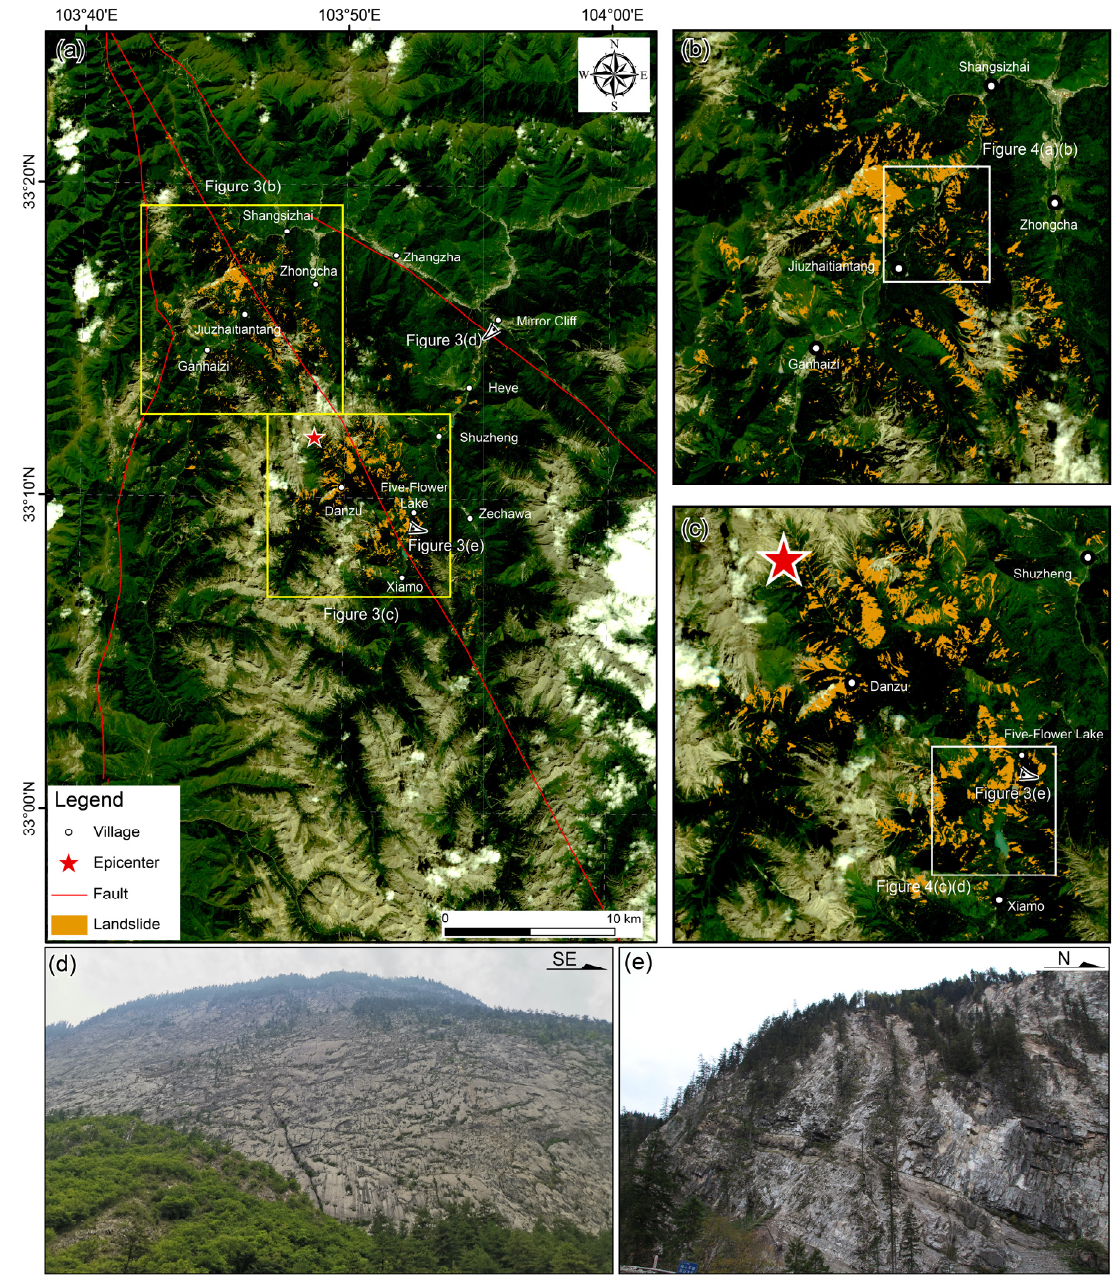
Figure 3. Inventory map of the earthquake-induced landslide in Jiuzhaigou. ( a ) Landslide map (The background is Sentinel-2 image (RGB)); ( b ) and ( c ) Landslide map of Jiuzhaitiantang and Panda Lake; ( d ) Outcrop of massive limestone developed near Mirror Cliff; ( e ) Outcrop of thick massive limestone observed near Five-Flower Lake.